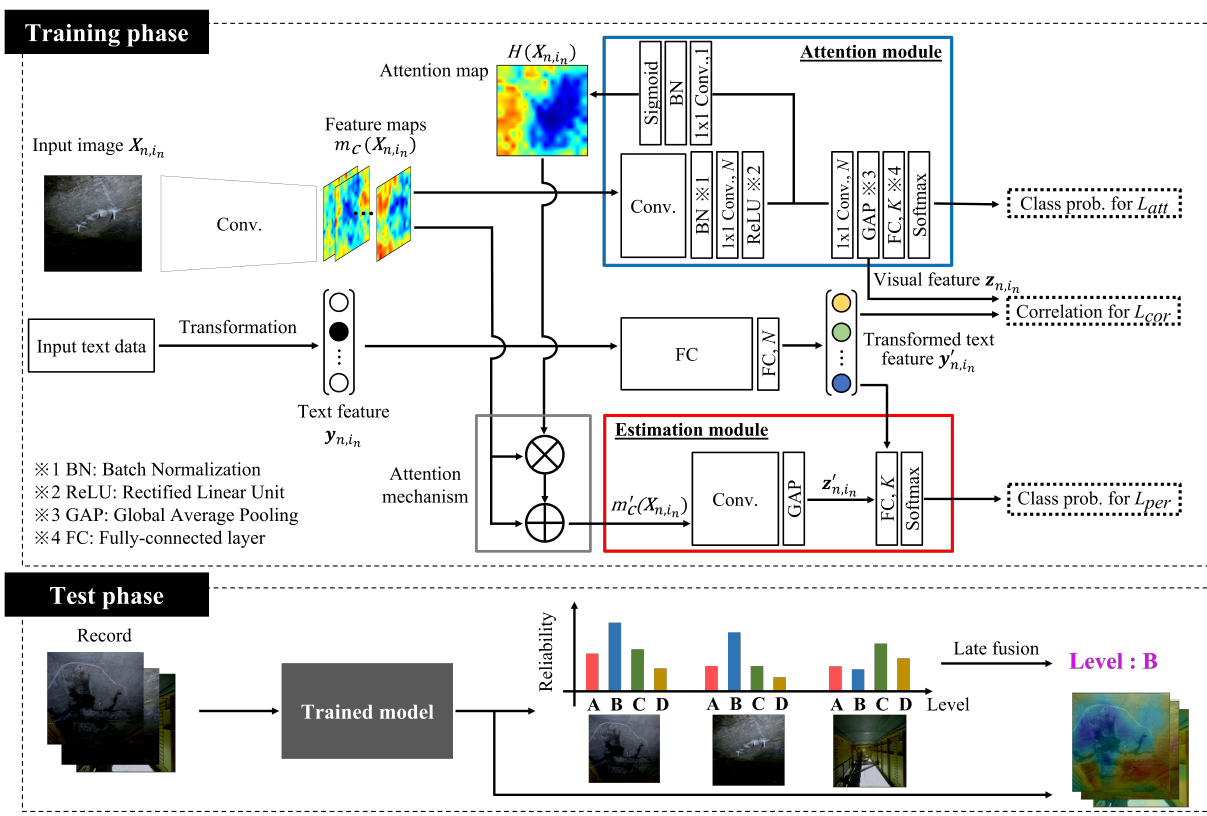
Figure 3. Overview of the proposed method. This model consists of the attention and estimation modules. Especially, we obtain reliable output by the estimation module when one distress image is given. Then we compare these reliabilities obtained from multi-view images, and the final estimation result with the attention map is obtained via the late